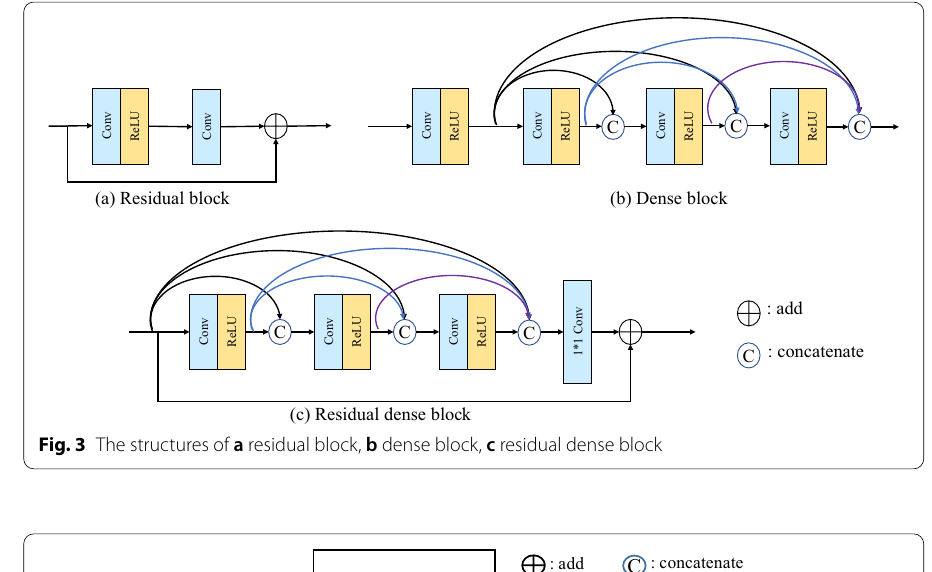
Fig. 3 The structures of a residual block, b dense block, c residual dense block